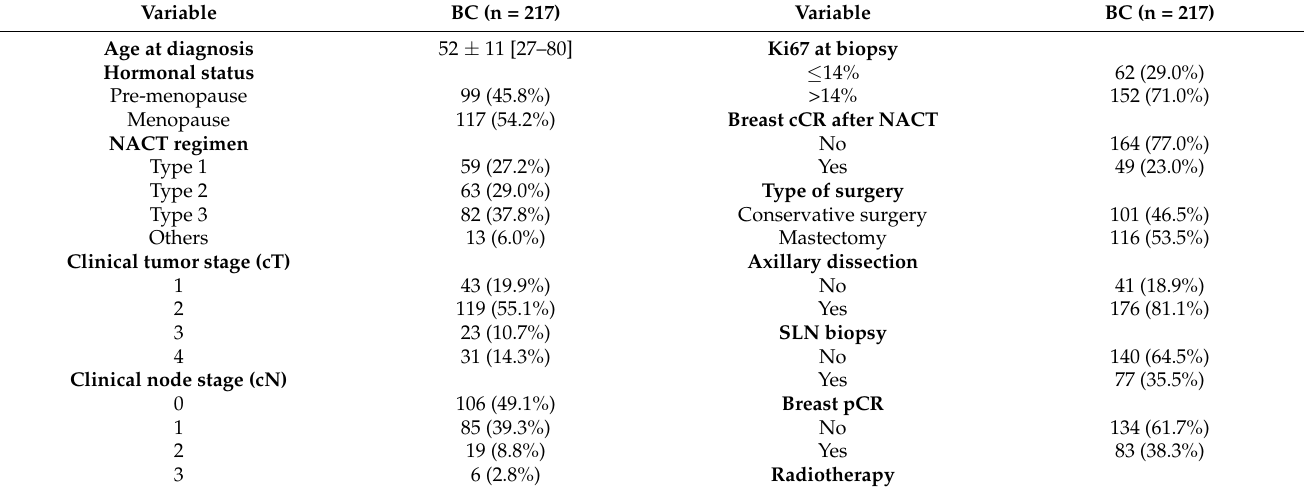
Table 1. Clinical and pathological characteristics of the study population (n = 217 breast